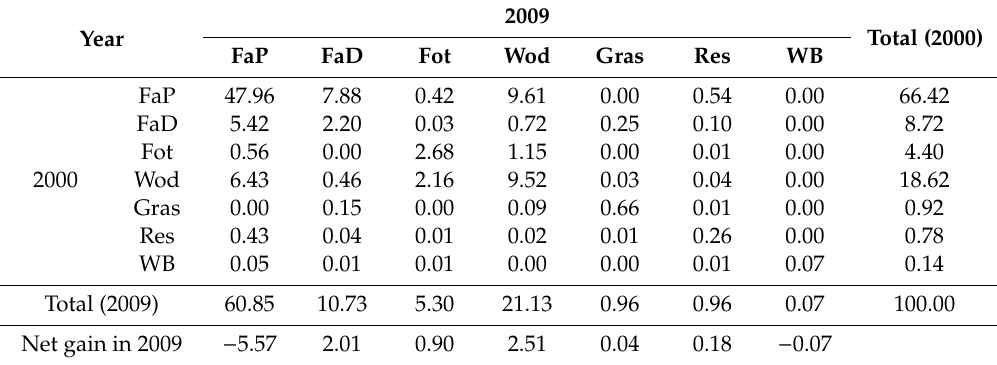
Table 3. Percentages of conversion of each LULC during 2000–2009 (% of total